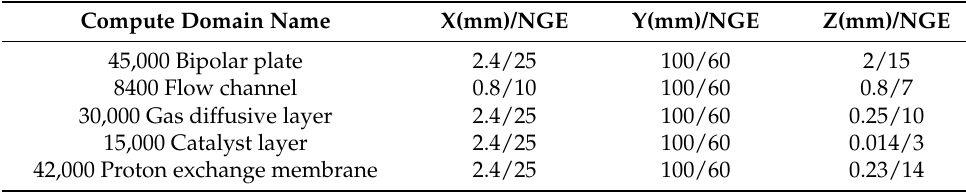
Table 3. Geometry parameters of PEMFC and the number of grid elements (NGE).